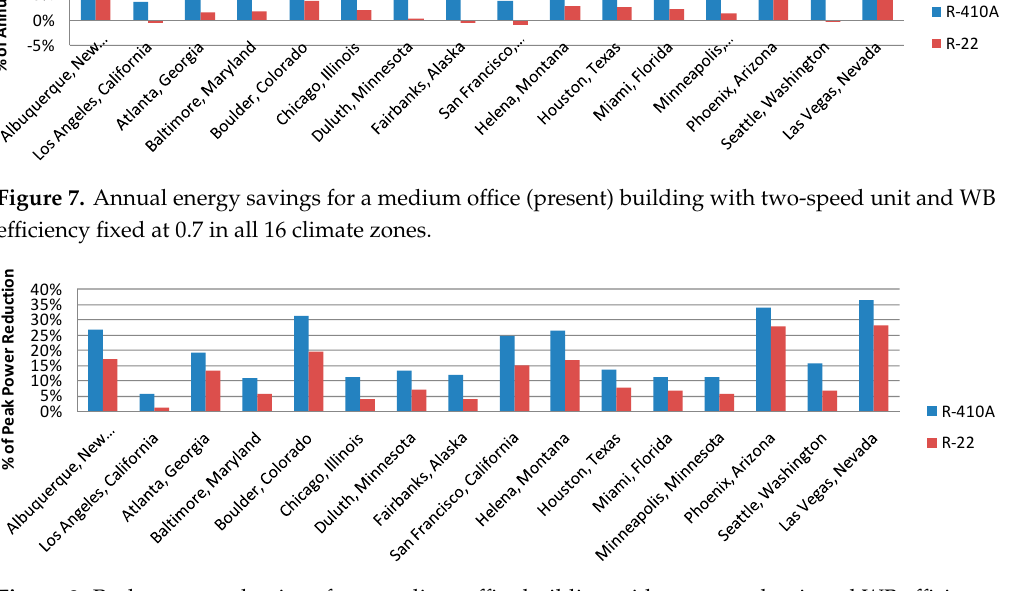
Figure 8. Peak power reductions for a medium office building with two-speed unit and WB efficiency fixed at 0.7, in 16 climate zones.